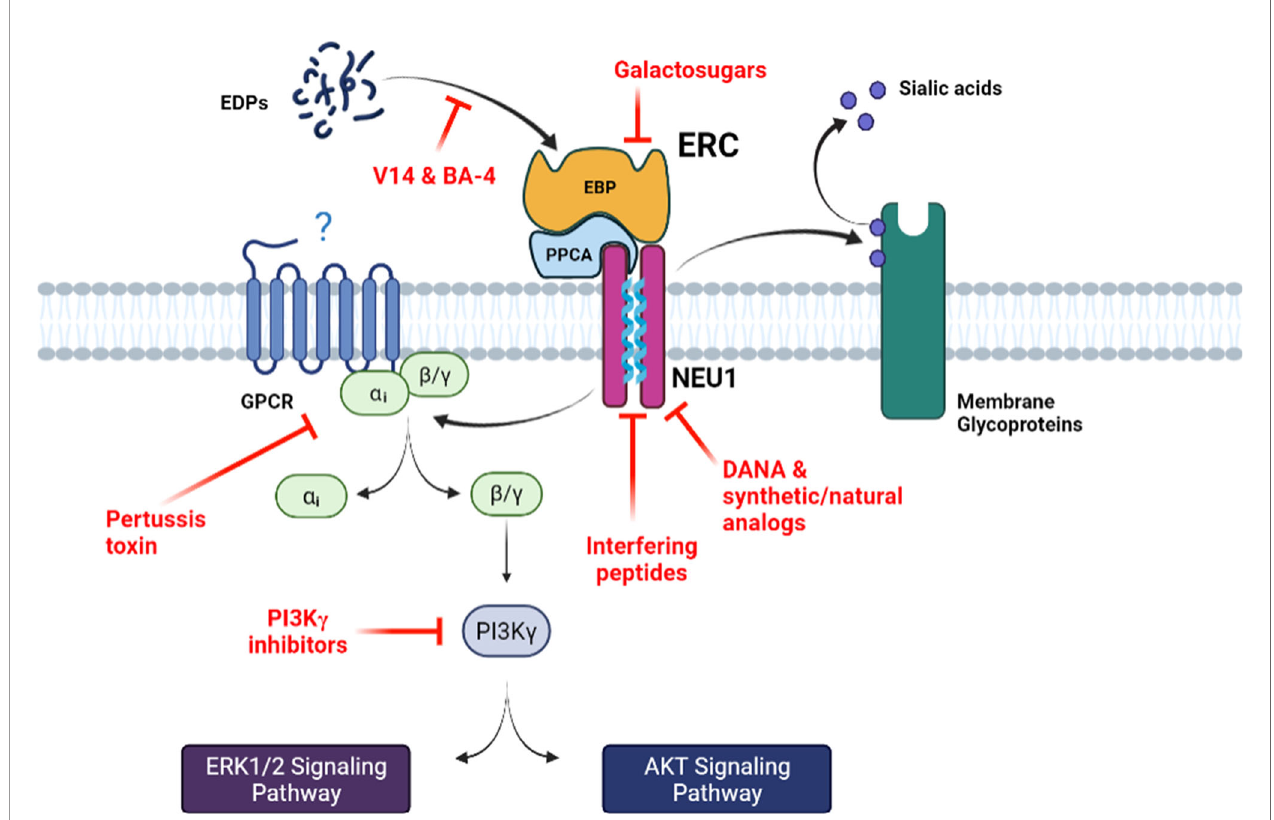
FIGURE 1 | The main signaling pathways mediated by the ERC and associated pharmacological inhibition strategies. Bioactive EDPs binding to the ERC triggers signaling pathways that involve G a i proteins and culminate to ERK1/2 and Akt activation. Increase in NEU1 sialidase activity following elastokines binding to the ERC can also modulate the sialylation level of membrane receptors at its vicinity. The different pharmacological strategies that block ERC activation and signaling, by either blocking the interaction between the elastokines and EBP, inducing EBP shedding or inhibiting NEU1 sialidase activity, are depicted. DANA, 2-deoxy-2,3-didehydro- N-acetylneuraminic acid; EBP, elastin-binding protein; EDPs, elastin-derived peptides; ERC, elastin receptor complex; GPCR, G-protein coupled receptor; NEU1, neuraminidase-1; PPCA, protective protein/cathepsin